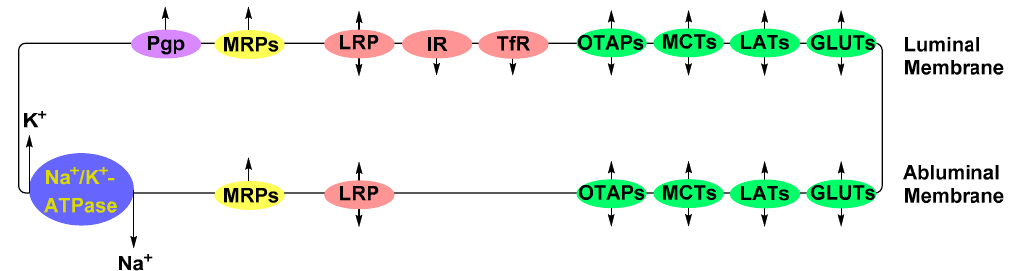
Figure 2. Major transporter proteins expressed by the endothelial cells (ECs) of the blood-brain barrier. Depicted in green are the solute-carrier bi-directional transport proteins that translocate glucose (GLUTs), large neutral amino acids (LATs), monocarboxylates, such as lactate (MCTs), and organic anion polypeptide (OATPs). Protein and peptide transporters depicted in red are the transferrin receptor (TfR), insulin receptor (IR) and low-density lipoprotein receptor-related protein (LPR). Multidrug-resistance-associated proteins and P-glycoprotein, depicted in yellow and purple, respectively, are e ffl ux pumps that transport xenobiotics against their concentration